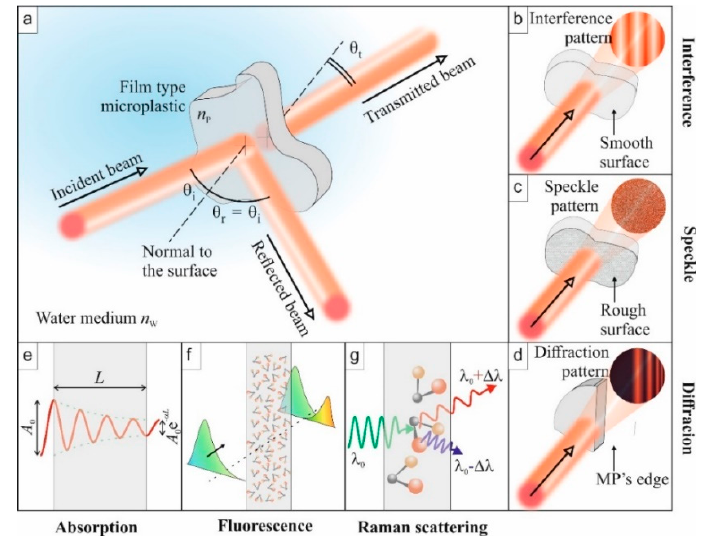
Figure 1. Illustration of some optical phenomena to be exploited for the identification of microplastic (MP) properties. ( a ) Overview of a standard experiment: the incident light is reflected, transmitted, and absorbed. ( b ) Interference: If the MP has two smooth surfaces, multiple reflections inside the film lead to an interferogram. ( c ) Speckle: Rough surfaces will generate a speckle originating from multiple interferences. ( d ) Diffraction: edges of the MP particles can diffract light beams to create organized patterns. ( e ) Absorption: the output amplitude is lower than the incident one. ( f ) Fluorescence: absorbed light energy is re-emitted at other wavelengths when molecules relax. ( g ) Raman scattering: specific light frequencies excite vibrational states of molecules, which lead to the emission of secondary photons at a slightly shifted frequency (Stokes and